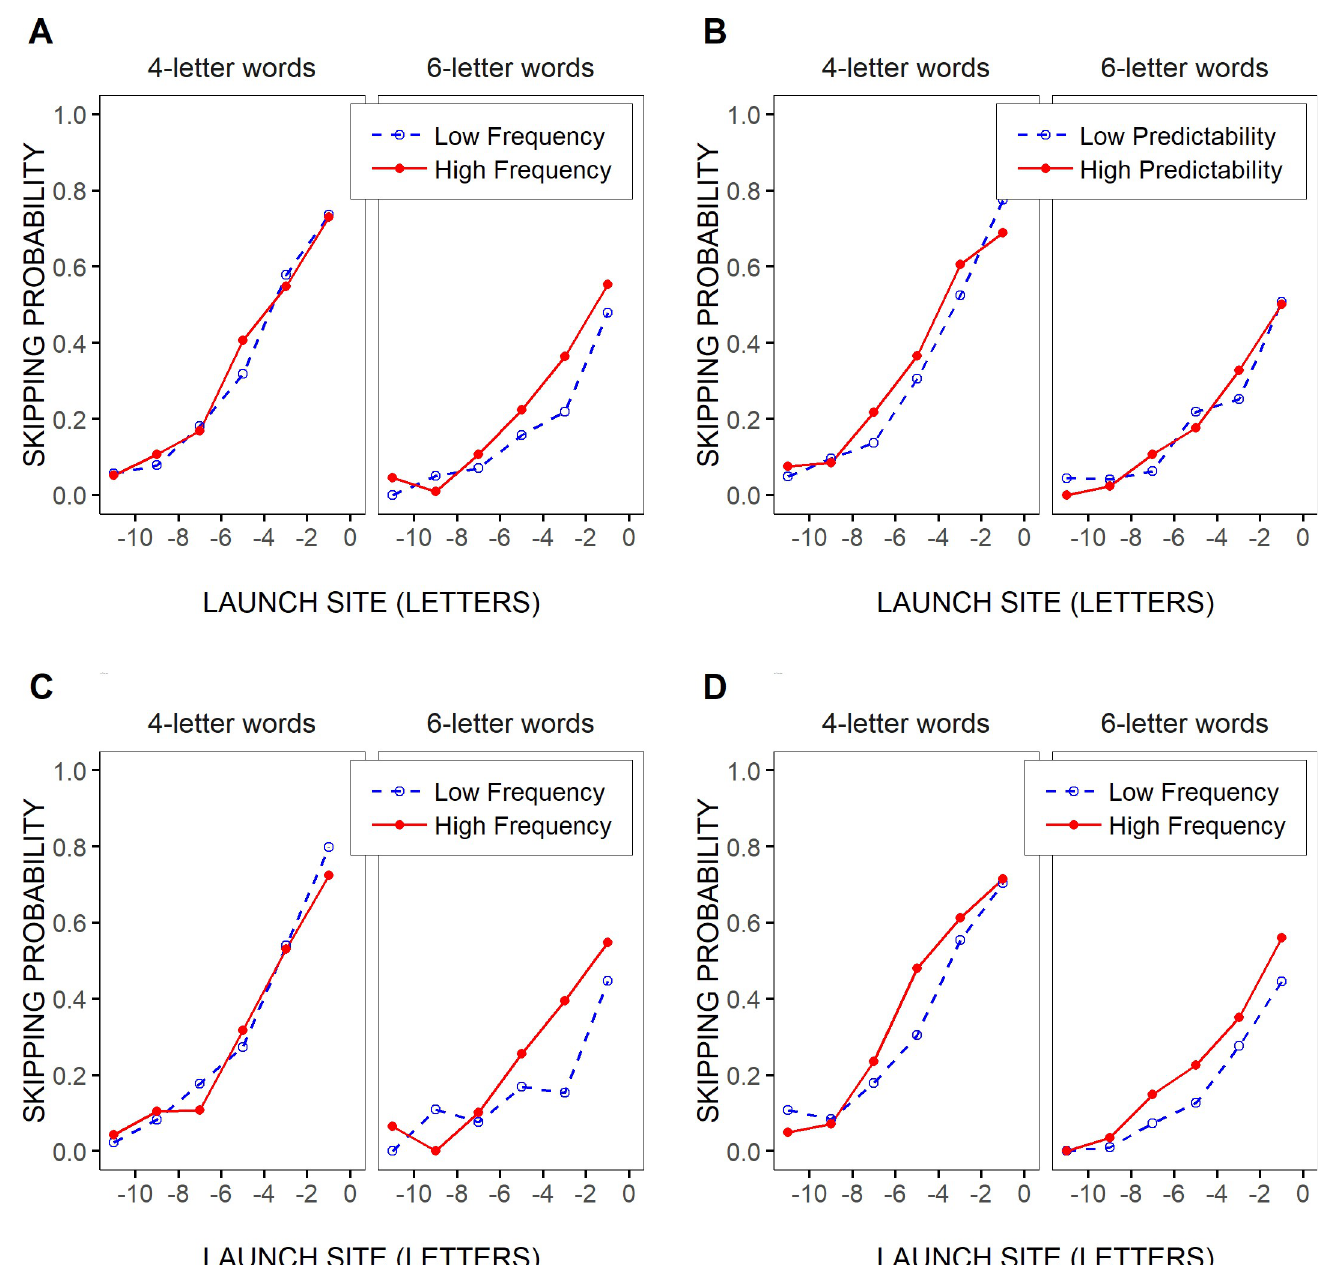
Fig 3. Test-word skipping rate by launch site, frequency and predictability. Mean probability of skipping 4- and 6-letter test words as a function of the saccades’ launch-site distance to the space in front of the words (binned in two-letter intervals), separately for two categories of test-word frequencies (across word predictabilities; A) and two categories of test-word predictabilities (across word frequencies; B), and for high- vs. low-frequency test words of low- and high- predictability (C and D respectively). The two categories of word frequencies and word predictabilities were determined after grouping test-word frequencies and predictabilities into two bins respectively (see Materials and